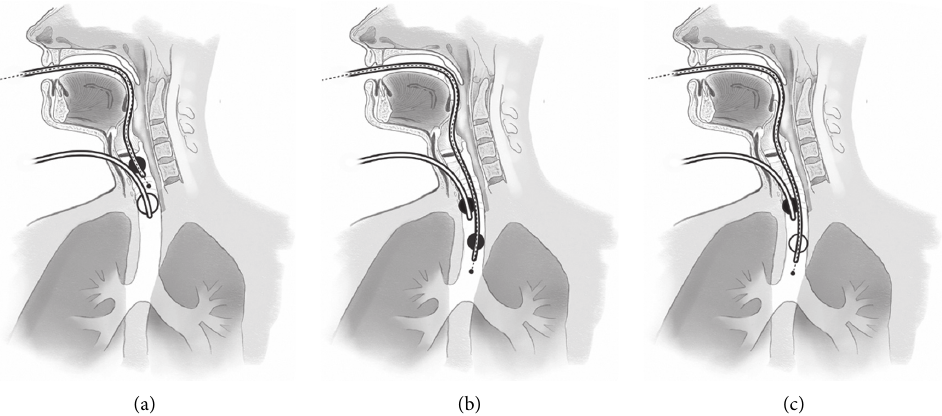
Figure 1: Simultaneous use of two endotracheal tubes. (a) The emergently placed ETT through the self-inflicted neck wound with the cuff inflated (white cuff) is used to ventilate the patient while a second ETT is passed from the oropharynx using a fiberoptic scope as a smart stylet (black dotted line in the tube). (b) The tracheal ETT cuff is deflated (black cuff) while the oral ETT is advanced over the fiberoptic scope. (c) The oral ETTcuff is inflated (white cuff) while the tracheal ETT is withdrawn and eventually taken out through the wound in the neck. A white cuff indicates an inflated cuff; a black cuff indicates a deflated cuff.